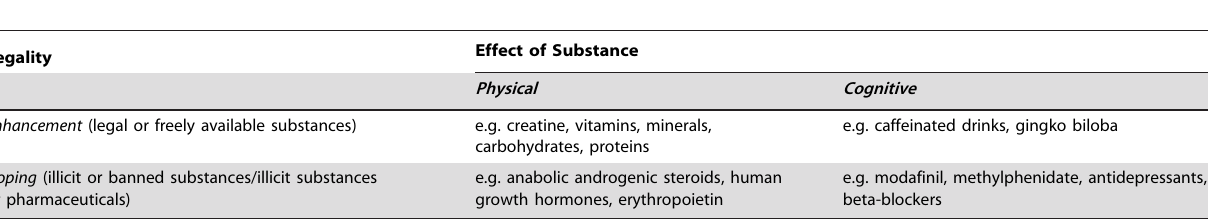
Table 1. Examples of legal and illicit substances that produce effects on the body and cognitive functions.